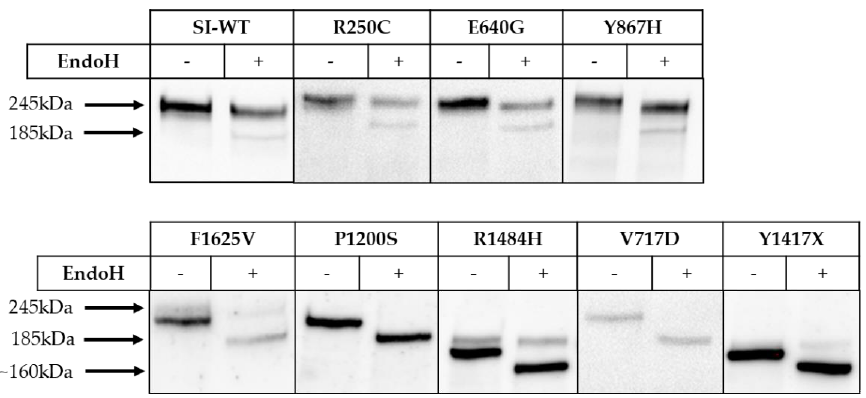
Figure 1. Biosynthetic forms of wild type sucrase-isomaltase (SI) (SI-WT) and SI mutants in COS-1 cells. SI-WT or SI- mutants (R250C, R1484H, E640G, F1625V, P1200S, Y867H, Y1417X and V717D) were expressed in COS-1 cells, immuno- in COS-1 cells. SI-WT or SI-mutants (R250C, R1484H, E640G, F1625V, P1200S, precipitated with mAb anti-SI and treated or not treated with endo H then analyzed by Western blotting. The mature, endo H-resistant form of SI has a molecular weight of 245 kDa; the mannose-rich ER form of SI (210 kDa) is sensitive to endo H and shifts to a lower Band at 185 kDa.